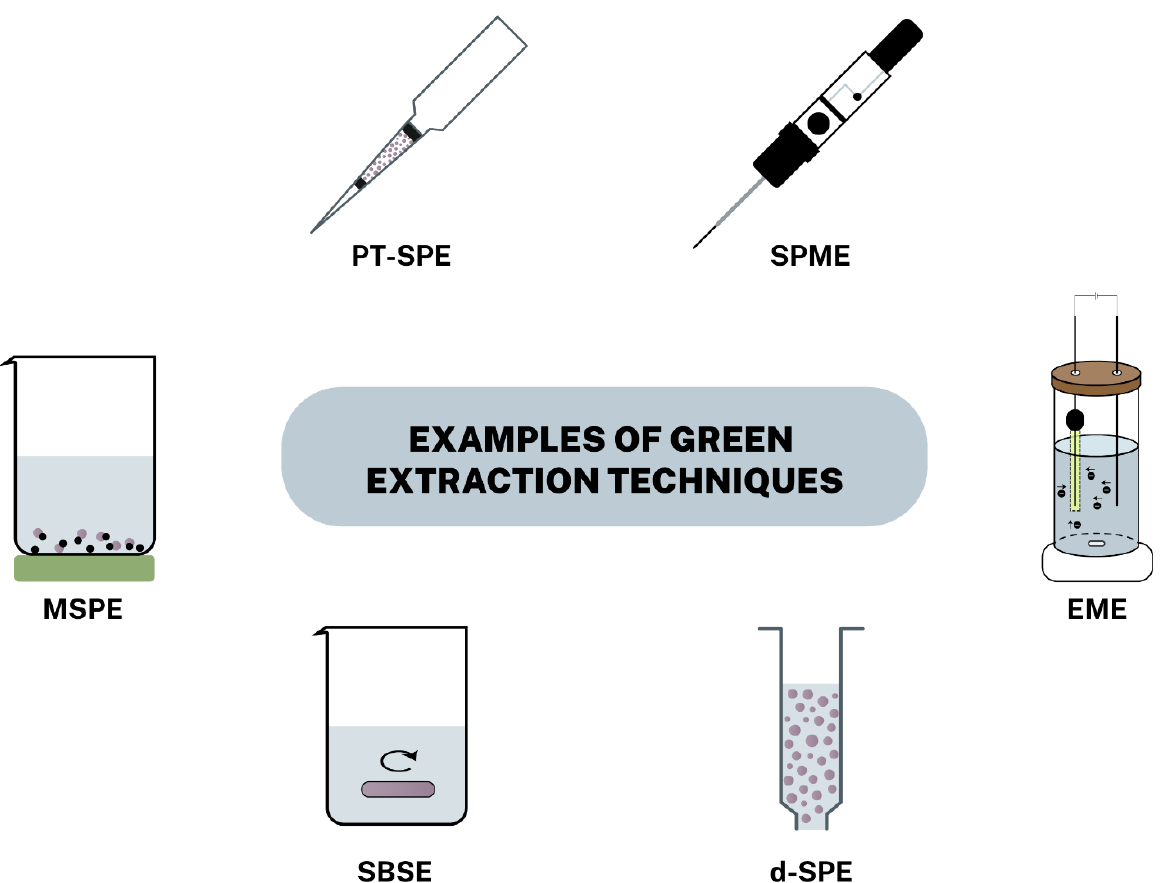
Figure 1. Examples of green extraction techniques utilizing MOFs as adsorbents. PT-SPE: Pipette tip solid-phase extraction, SPME: Solid-phase microextraction, EME: Electromembrane extraction, d-SPE: dispersive solid-phase extraction, SBSE: Stir bar sorptive extraction, MSPE: Magnetic solid-phase extraction.